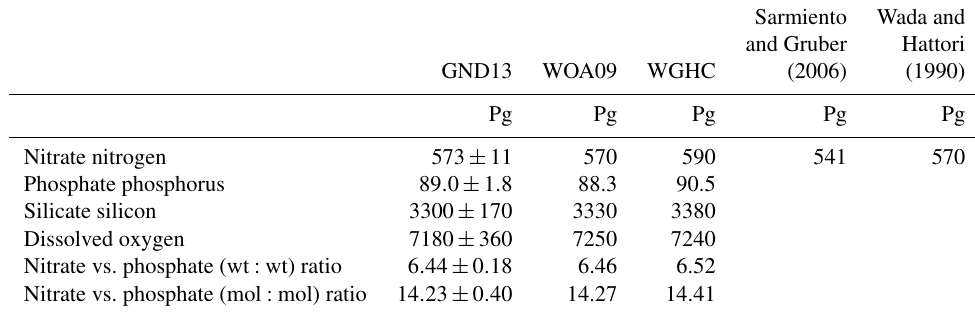
Table 4. Total amounts of nitrate nitrogen, phosphate phosphorous, silicate silicon, and dissolved oxygen and nitrate vs. phosphate ratios in the global